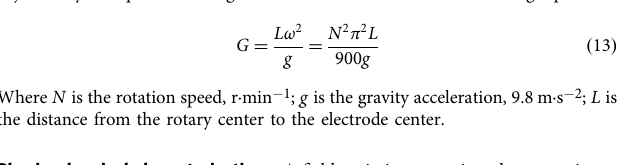
Supplementary Table 2. All cells (coin cells and pouch cells) were monitored in a LAND